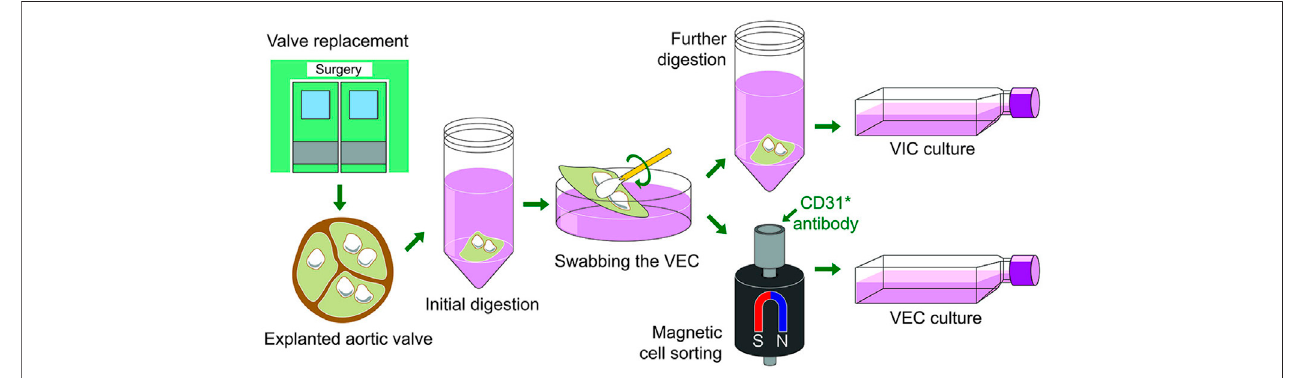
FIGURE 2 | A schematic overview of the main steps of the calci fi ed human aortic valves collection, digestion and valvular interstitial and endothelial cells isolation.